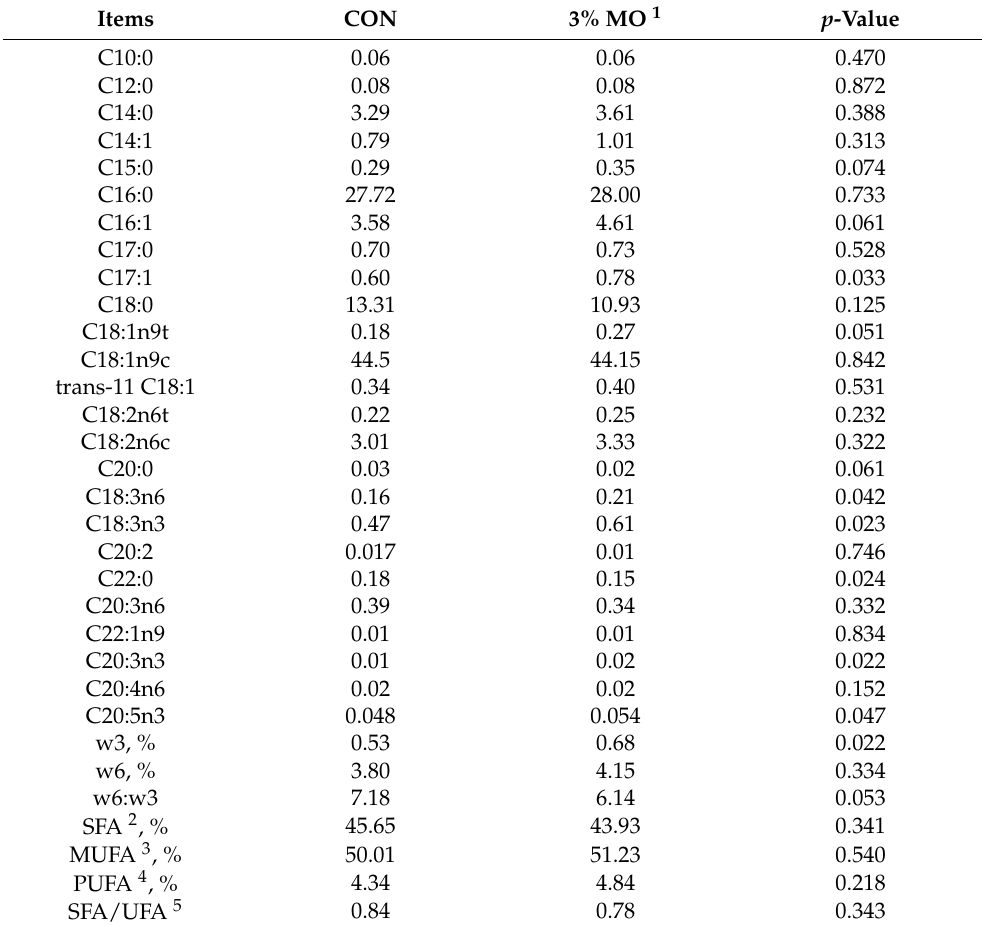
Table 8. Effect of 3% rumen-protected microencapsulated supplement (MO) on the fatty acid compo- sition (%) of intramuscular fat in steers.